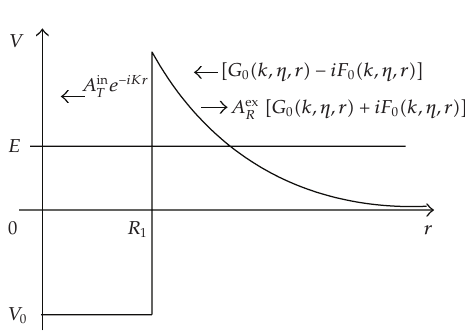
Figure 13: Schematic description of the impact of a wave packet with a Coulomb barrier from outside.